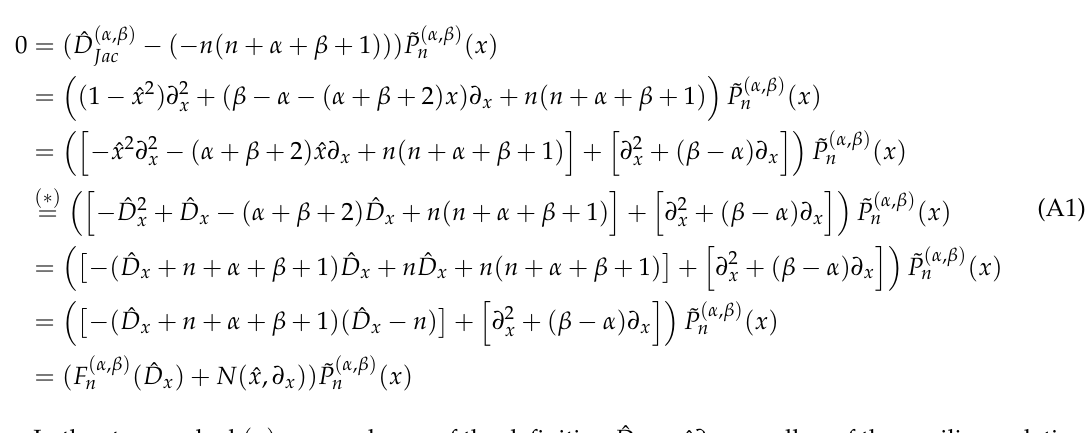
( − 1, − 1 ) ( x ) and bi-variate Hermite polynomials H n ( x , y ) n